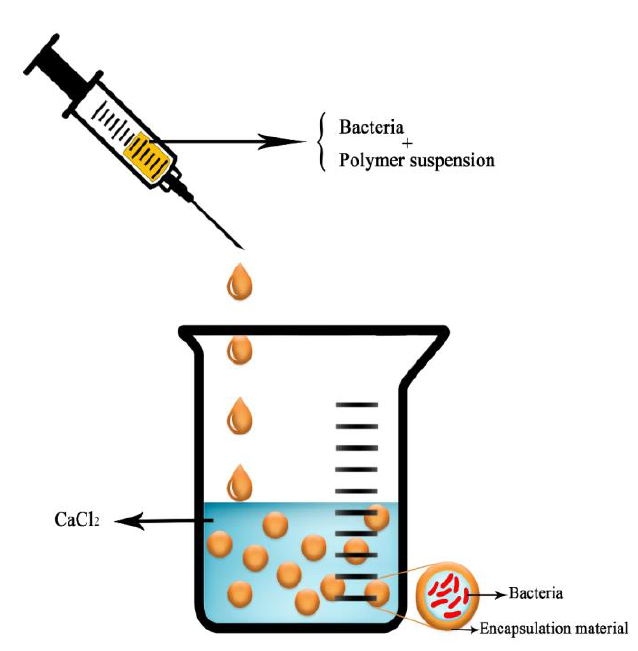
Figure 3. Schematic picture of the extrusion technique for bacteria encapsulation.